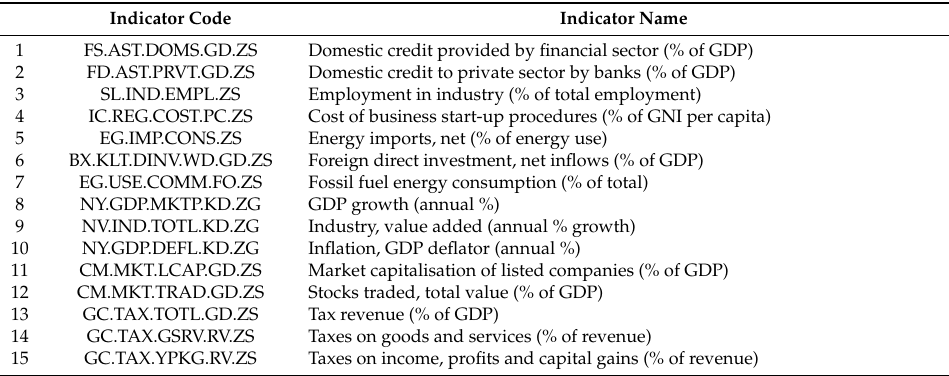
Table A1. Indicators from [40] that can serve as potential predictors of the parameters K that collects the overall effect of the